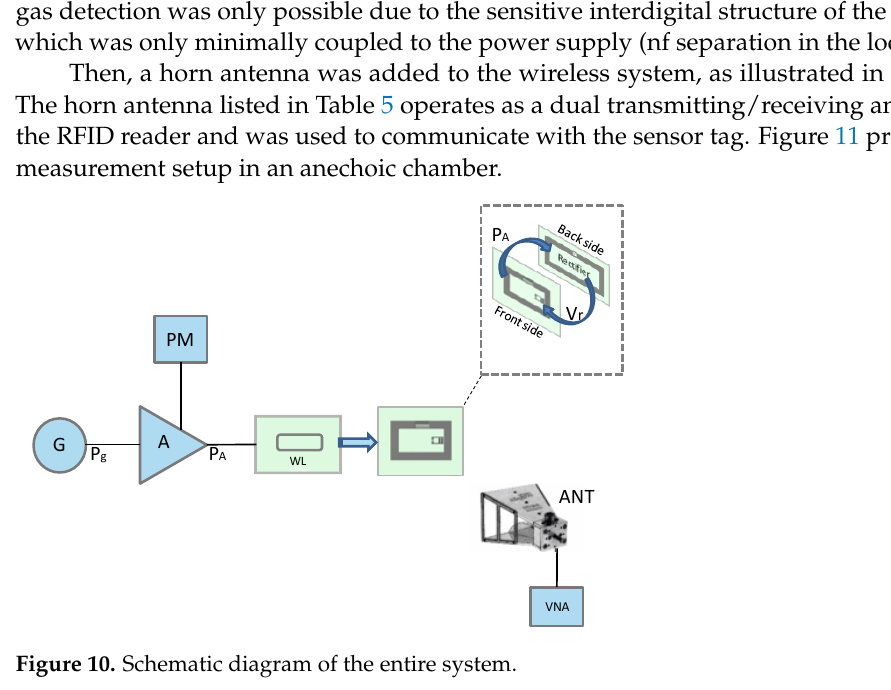
Table 4. Measured input power and the corresponding rectifier voltage.